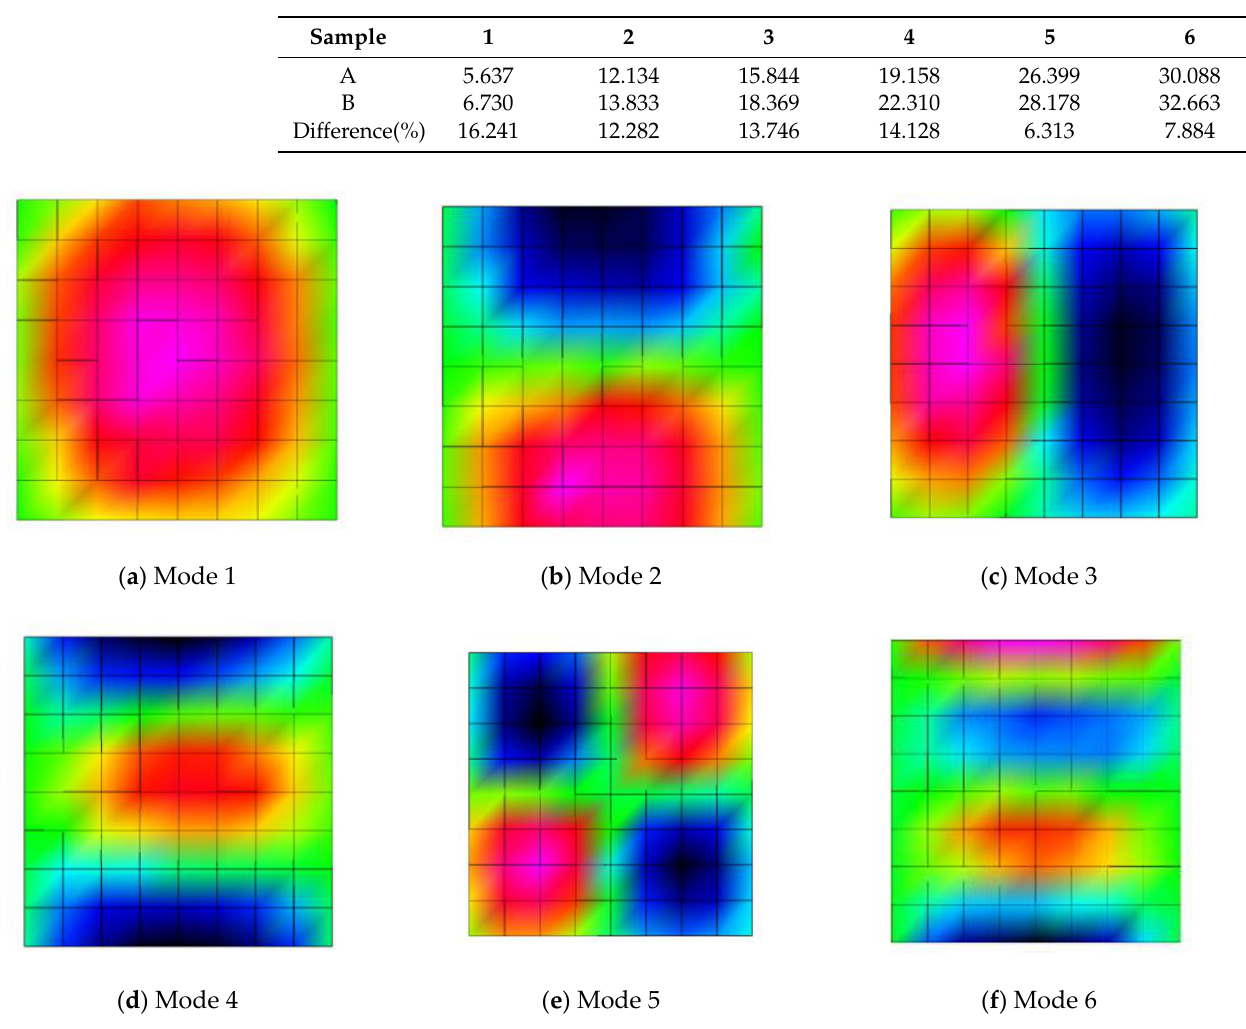
Figure 4. The first six measured modal shapes of panel units.